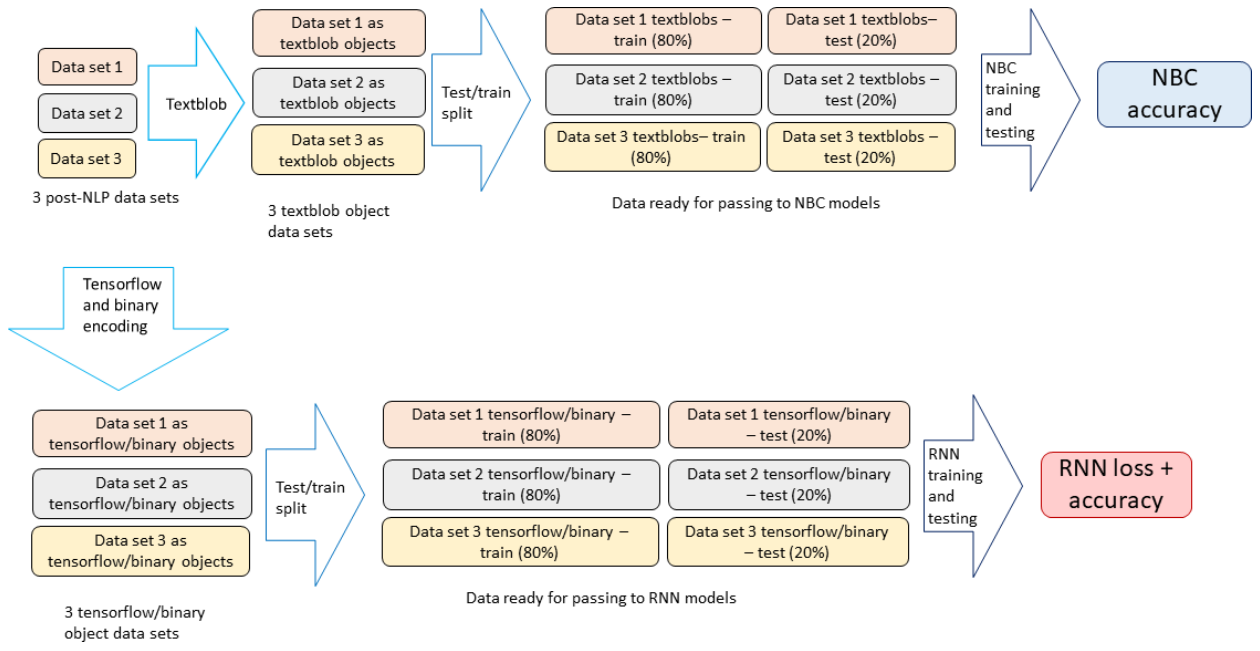
Figure 3. Both models follow similar steps using the 3 post-NLP data sets produced by the data collection and preparation steps. Each model encodes the data, splits it into training and testing subsets, and then applies the specific ML model processes to produce accuracy scores as